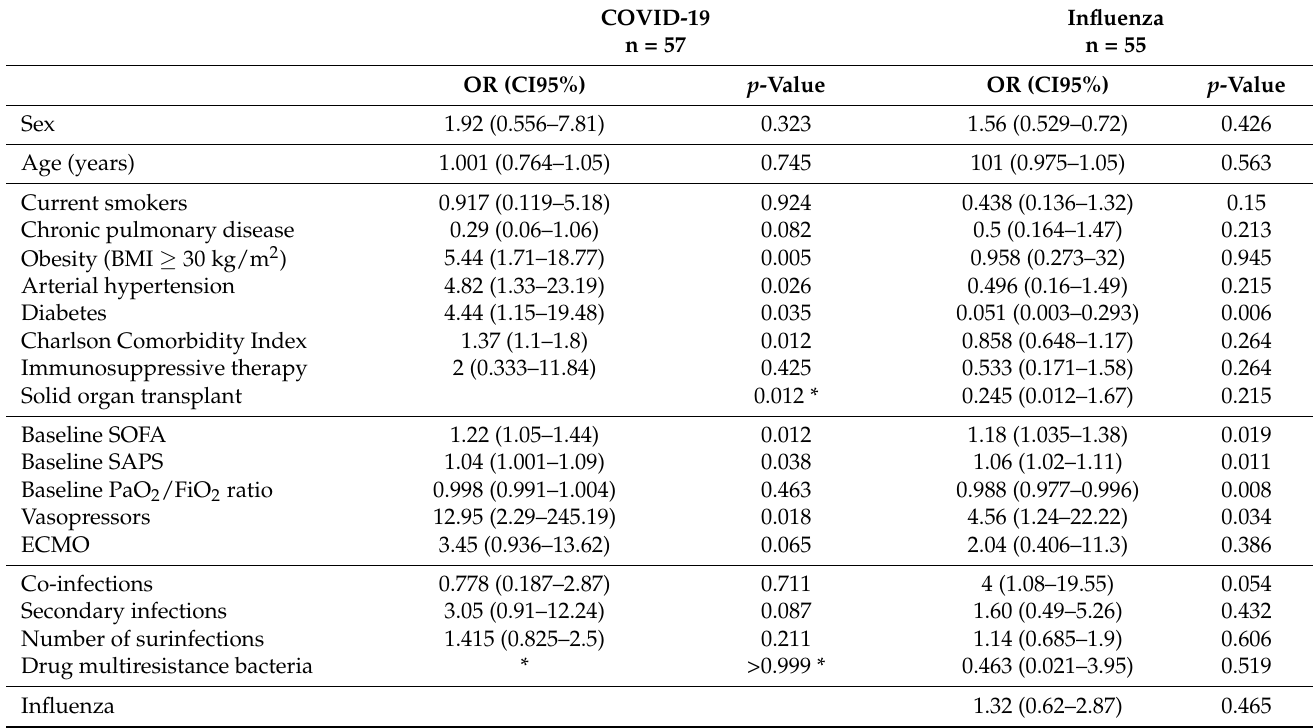
Table 7. Univariate analysis of the risk factors for ICU